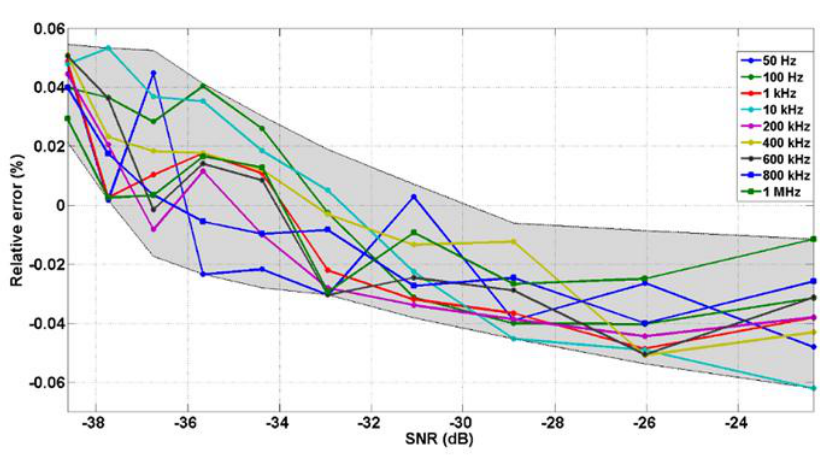
Figure 11. Relative error vs. SNR for a 10 mV rms square input signal buried in white noise. Grey area corresponds to the area between the lower and upper limits of the recovery